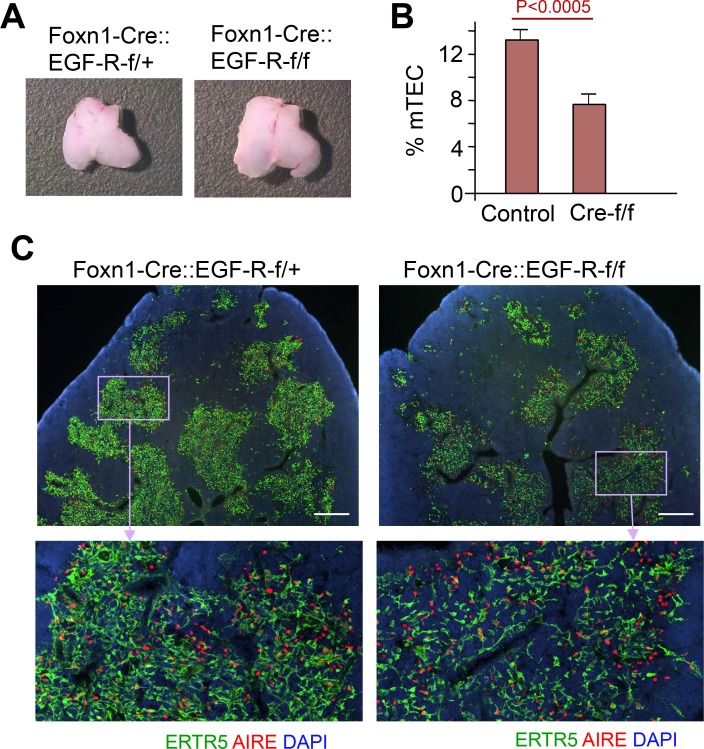
mTECs are reduced in Foxn1-EGF-R-CKO mice.(A) Gross anatomical analysis of the thymus derived from Foxn1Cre::EGF-Rf/+ mice (control) and Foxn1Cre::EGF-Rf/f mice at 6 weeks of age. (B) Quantitative analysis for the proportion of medullary regions in thymus of control (containing Cre-f/+ and f/f, n = 4) and mutant (Cre-f/f, n = 5) mice. (C) Cryostat sections of the thymus were stained with ER-TR5 antibody (green) and anti-AIRE antibody (red). Sections were counterstained with DAPI (blue). Scale bars: 400 μm.